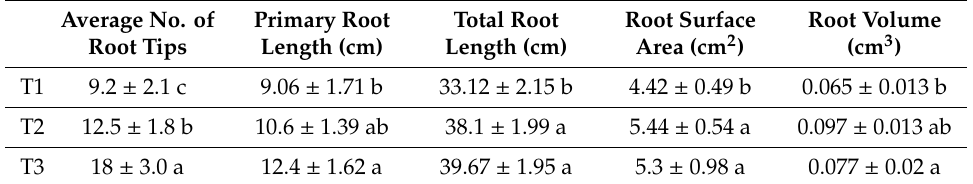
Table 1. Root morphological characteristics of masson pine seedlings treated with di ff erent N-sources, i.e., T1, T2, and